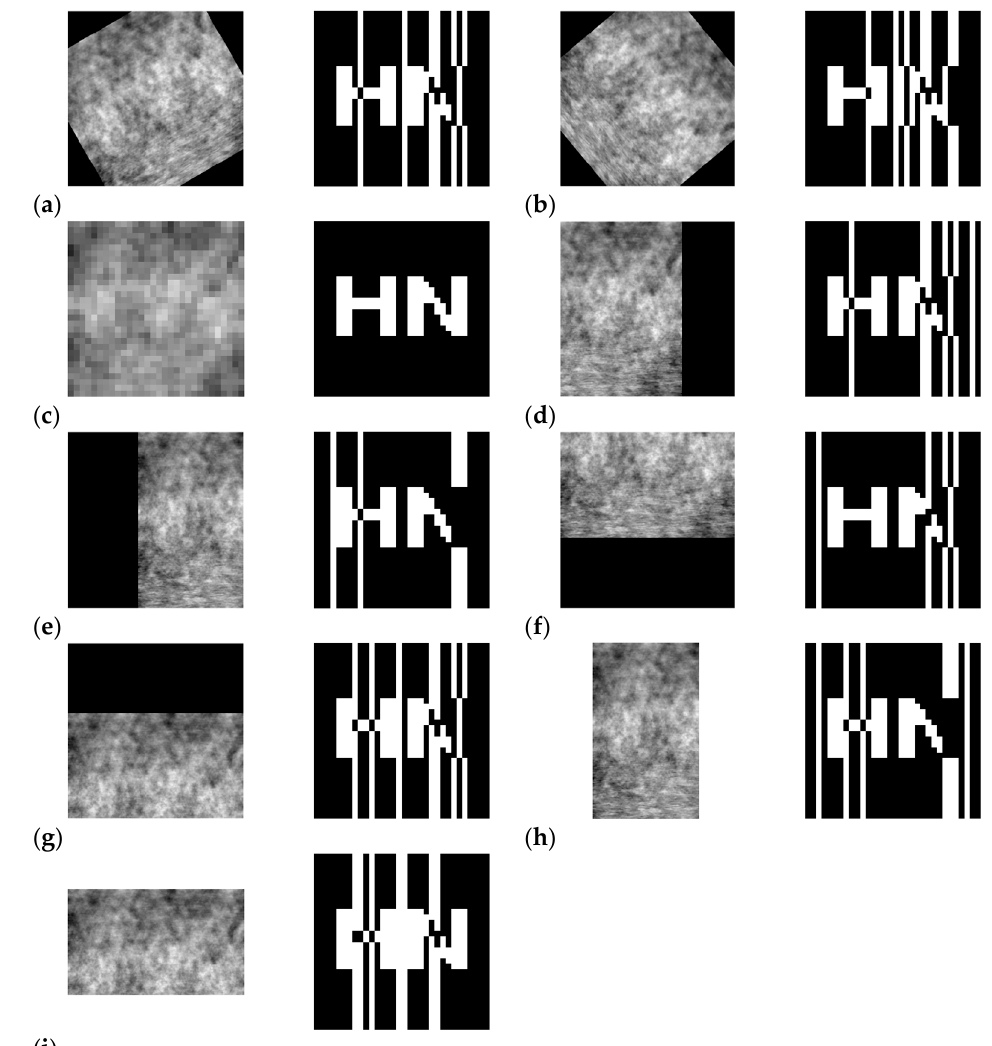
Figure 14. Encrypted medical images and extracted watermarks after some geometric attacks. Image and extracted watermark after 30° counterclockwise rotation ( a ), image and extracted watermark after 50° clockwise rotation ( b ), image and extracted watermark after 0.1 times scaling ( c ), image and extracted watermark after 30% left-shift ( d ), image and extracted watermark after 40% right-shift ( e ), image and extracted watermark after 40% up-shift ( f ), image and extracted watermark after 40% down-shift ( g ), image and extracted watermark after 40% clipping in X-axis direction ( h ), and image and extracted watermark after 40% clipping in Y-axis direction watermark ( i